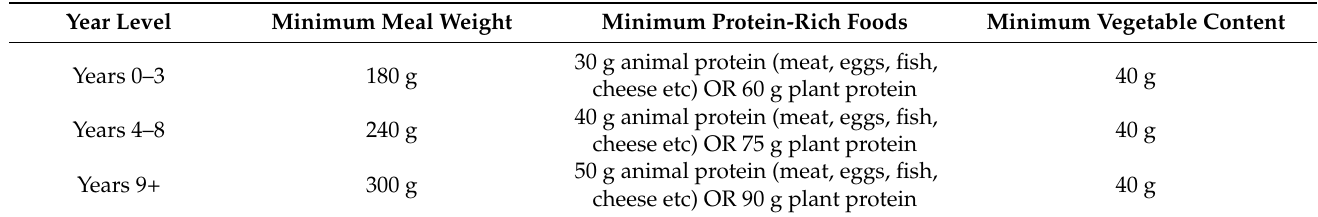
Table 1. Meal requirements on Ka Ora, Ka Ako|Healthy School Lunch